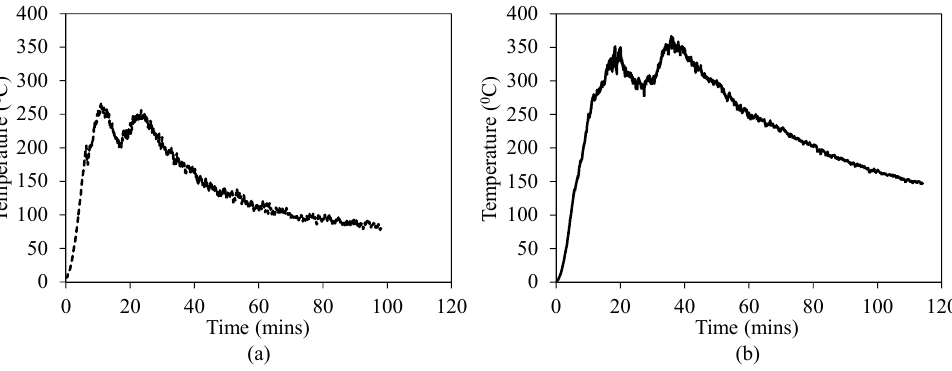
Figure 6. Temperature-time relationship of TRM test specimens in the third series: ( a ) maximum temperature of 250 ◦ C and ( b ) maximum temperature of 350 ◦ C